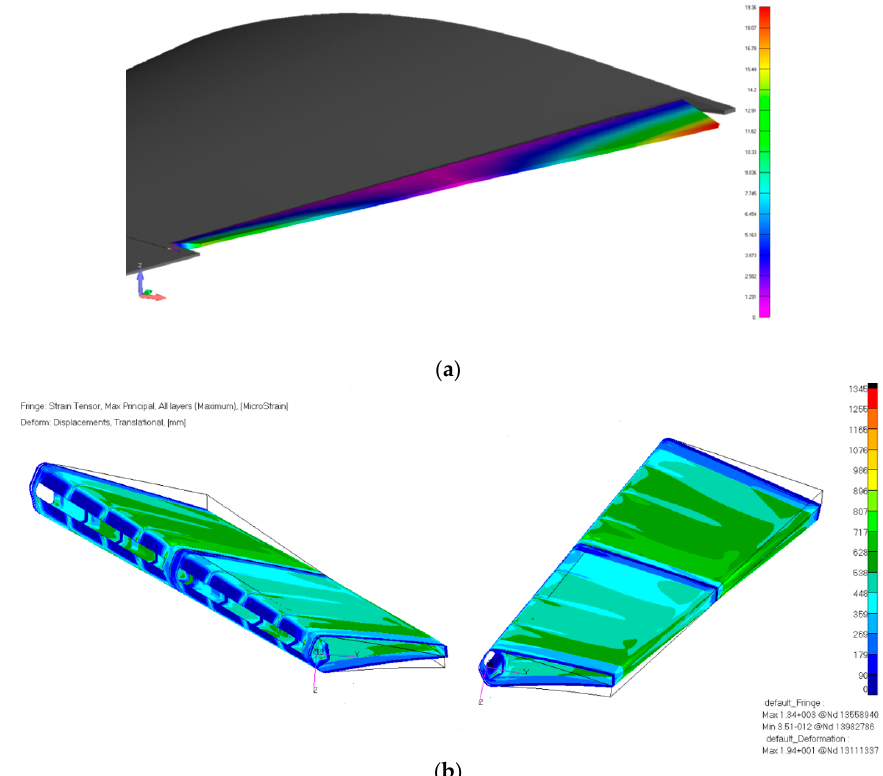
Figure 16. Finite Element analysis with the maximum linear twist for Mode B from tip to root section ( − 5°/0°/+5°): ( a ) Displacement (mm); ( b ) Strain distribution, Max Principal [MicroStrain].